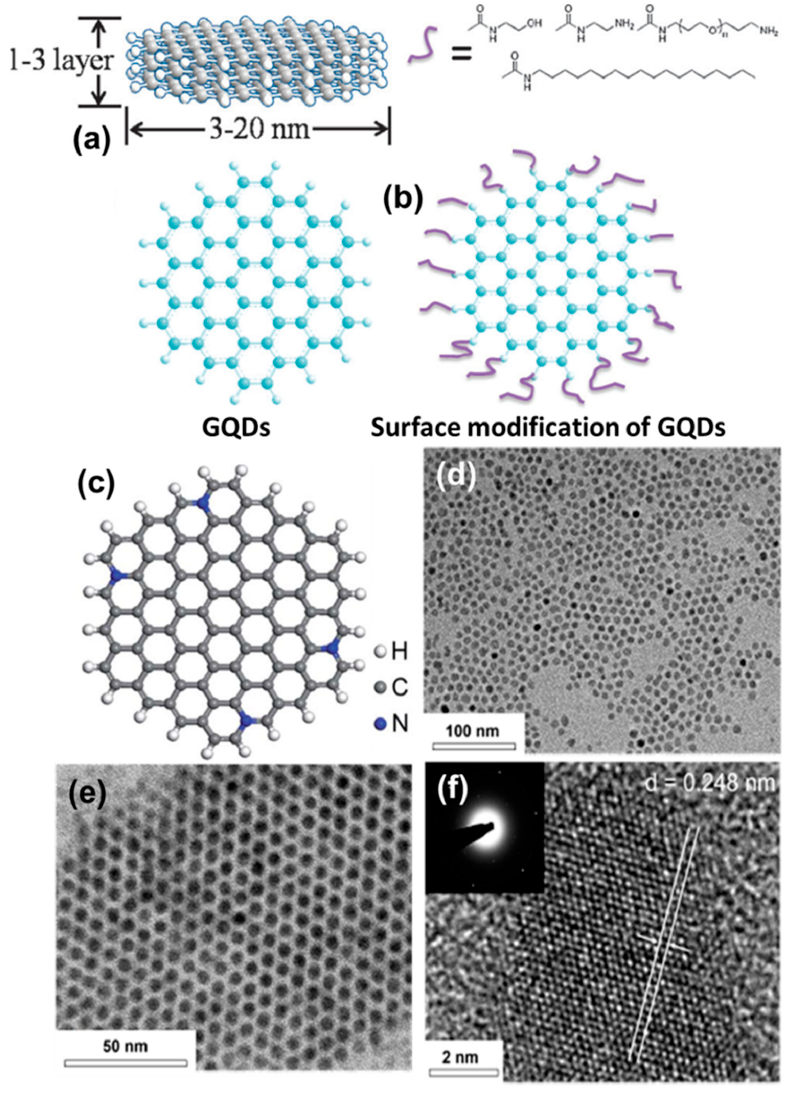
Figure 10. ( a ) Illustration for a few layers of stacked graphene in the QD system and ( b ) surface modification of colloidal GQDs with the help of ligands or functional groups. Reprinted with per- mission from Ref. [83]. ( c ) Optimized structure of a heteroatom doped GQDs. Reprinted with per- mission from Ref. [84]. Representative ( d , e ) TEM and ( f ) HRTEM images of GQDs. Reprinted with permission from Ref. [88].